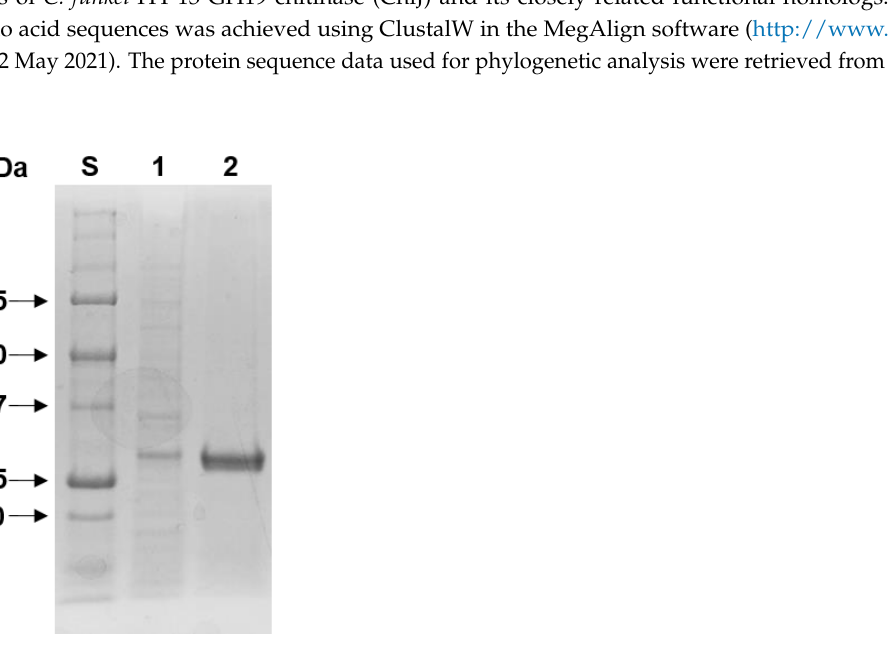
Figure 3. SDS-PAGE of the purified rChiJ after affinity chromatography on HisTrap HP. Lane S, standard marker proteins; lane 1, the total cell lysate of rChiJ-expressing E. coli BL21 after IPTG induction; lane 2, purified rChiJ. Table 1. Enzymatic characteristics of GH19 Chitinases (E.C.3.2.1.14) active for chitin polysaccharides.